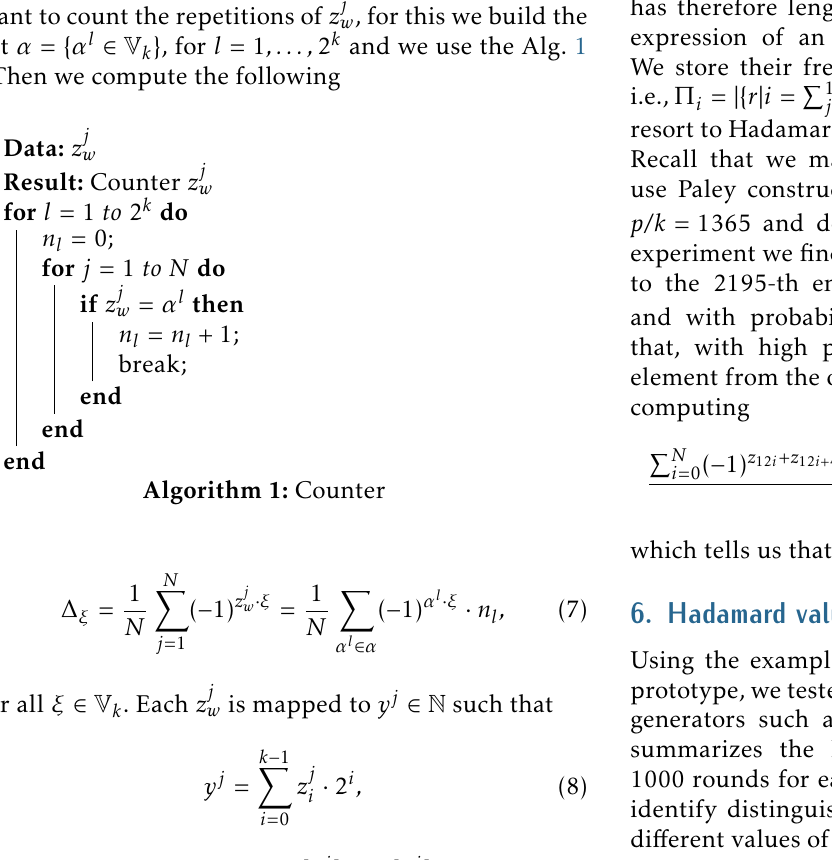
Table 2. Hadamard values for 1000 rounds for A 5 / 1 , Blow-fish and SG